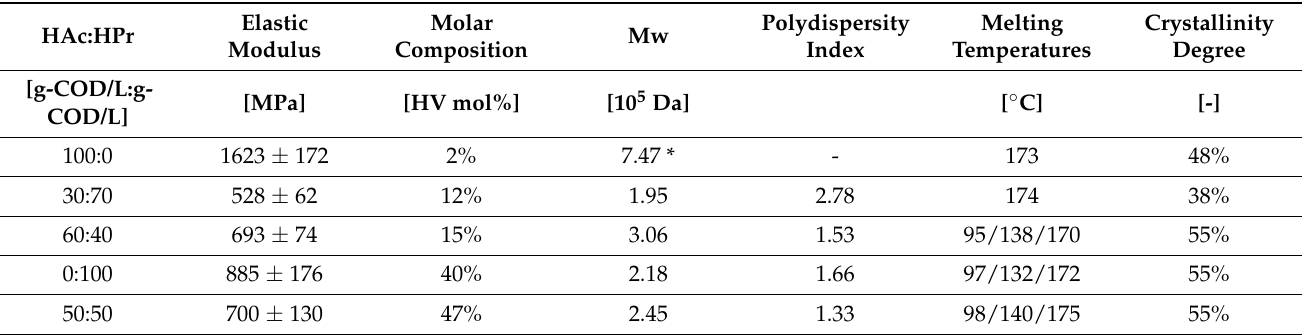
Table 1. Extracted PHA molar composition, elastic modulus from AFM force–distance curves on thin film, weight-average molecular weight Mw, polydispersity index and thermal